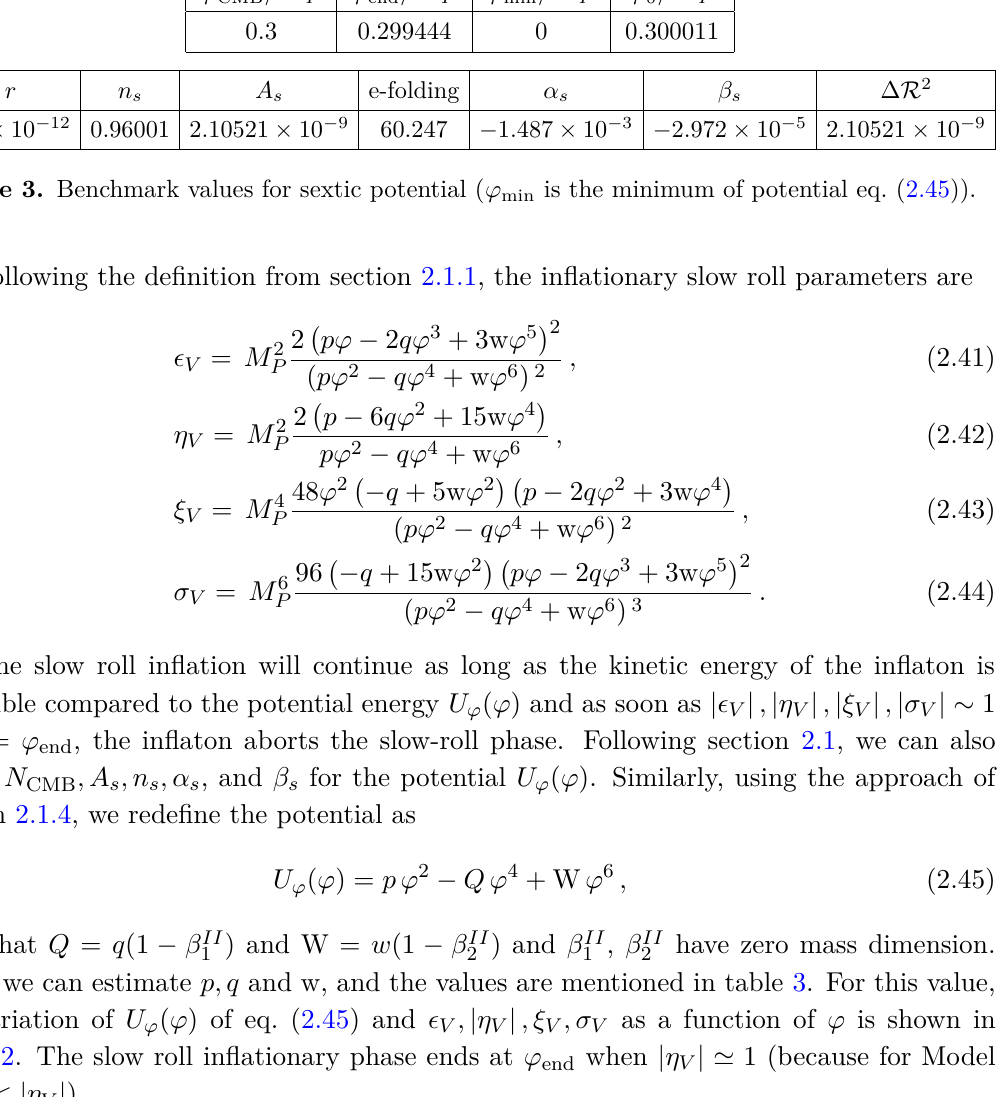
when | η | ’ 1 (because for Model V end